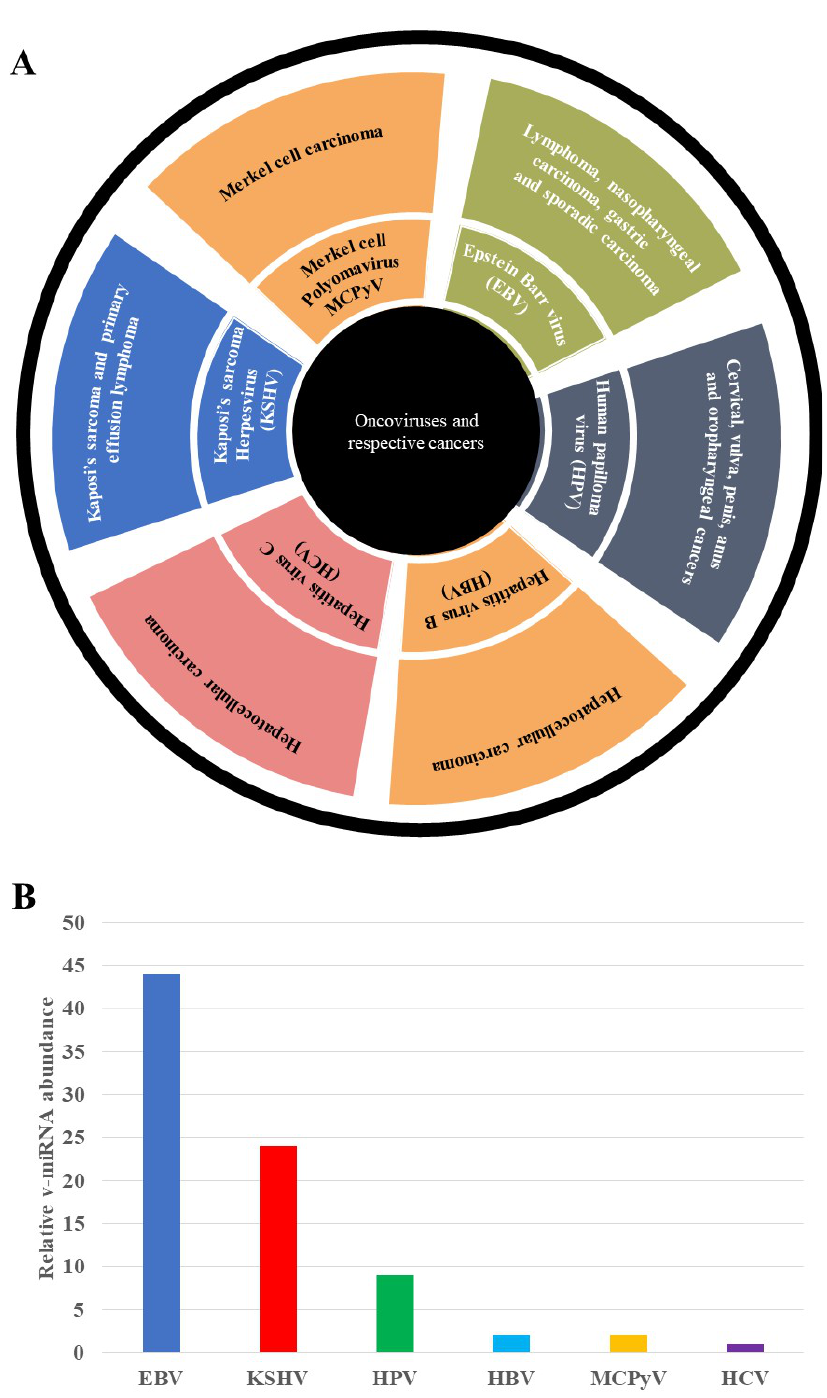
Figure 1. Oncogenic viruses in precision oncology. ( A ) Summary of oncoviruses and their associ- ated tumors. These oncoviruses include EBV, HPV, KSHV, HBV, HCB and MCPyV. Cancers asso- ciated with these viruses include Hodgkin’s lymphoma, cervical cancer, Kaposi sarcoma, liver can- cer and Merkel cell carcinomas. ( B ) Representation of relative v-miRNA abundance. EBV v-miRNAs relative abundance is higher than the other v-miRNAs, followed by KSHV, HPV, HBV, and no HCV* v-miRNA has been confirmed to date [10]